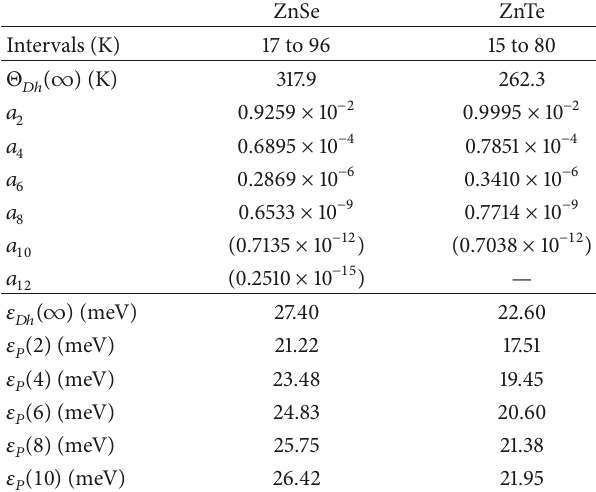
Table 10: Limiting values of the “true” (harmonic lattice) Debye temperatures, Θ 𝐷ℎ (∞) , including adjusted magnitudes of several even-order expansion coefficients, 𝑎 2𝑠 , that are representing the weights of the individual (Θ 𝐷ℎ (∞)/𝑇) 2𝑠 power terms in (C.1). These sets of parameter values have been determined via fittings (shown in Figure 10) of an appropriate selection of usable Debye temperature points, Θ 𝐷ℎ (𝑇) ≅ Θ 𝐷 (𝑇) , implied by the experimental 𝐶 (𝑇) data points given by Kremer et al. [46] for natural ZnSe 𝑝 and ZnTe. Listed are also the magnitudes of the respective (Debye- model-related) cut-off phonon energies, 𝜀 𝐷ℎ (∞) ≡ 𝑘 𝐵 Θ 𝐷ℎ (∞) , and several even -order phonon energy values, 𝜀 𝑃 (2𝑠) ≡ (𝜇 (2𝑠) 𝑃 ) 1/2𝑠 (for 2𝑠 =